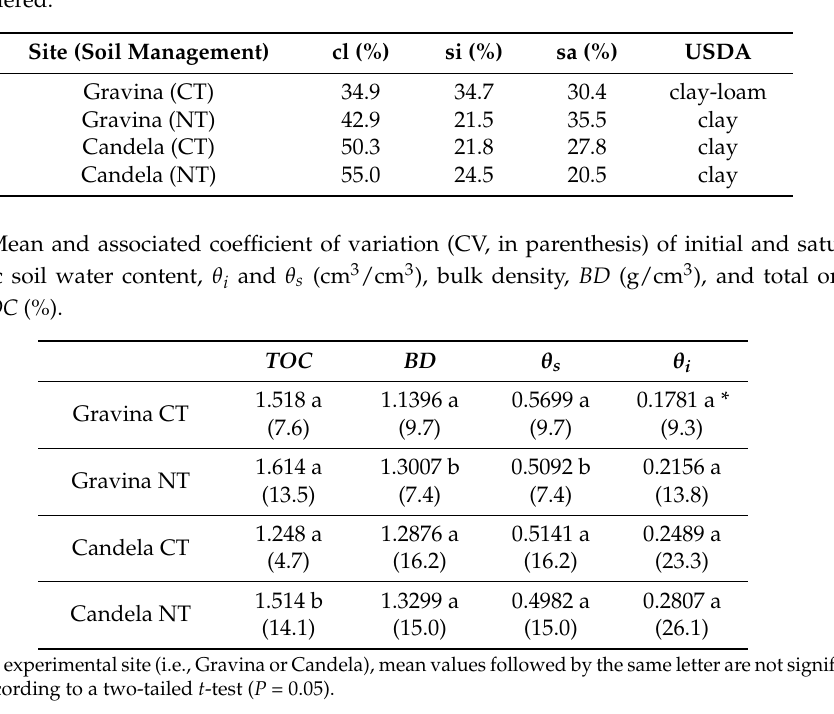
Table 2. Clay ( cl ), silt ( si ), and sand ( sa ) contents (0–0.1-m depth) according to the USDA classification for sites (Gravina and Candela) and soil managements (conventional tillage, CT and no-tillage, NT) considered.